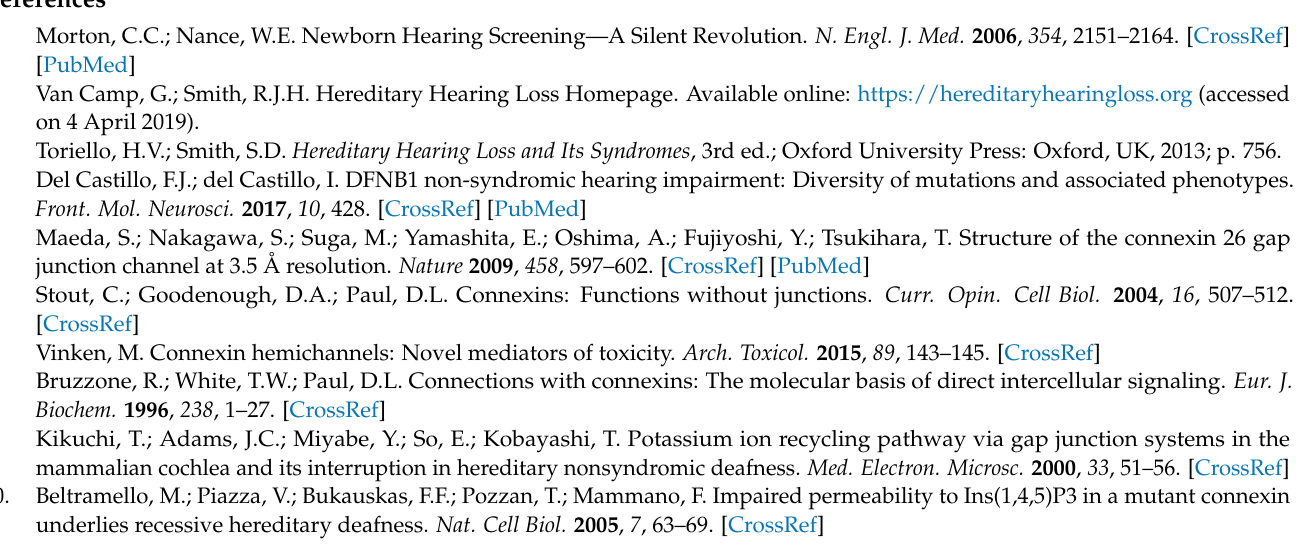
Figure 3), Figure S2: PI loading through Cx26-hemichannels in examined HeLa cell lines (fluorescent microscopy). KO, WT, W172C, R75Q, and 35delG denote lines HeLa Cx26-KO, HeLa-Cx26wt, HeLa- p.W172C, HeLa-p.R75Q, and HeLa-c.35delG, respectively. Green color corresponds to GFP signal, red color corresponds to PI signal. Scale bar = 200 µ m, Table S1: Missense variants of the GJB2 gene in the extracellular loop 2 (E2) of Connexin 26 defined as ‘pathogenic’ and ‘likely pathogenic’ in the Deafness Variation Database